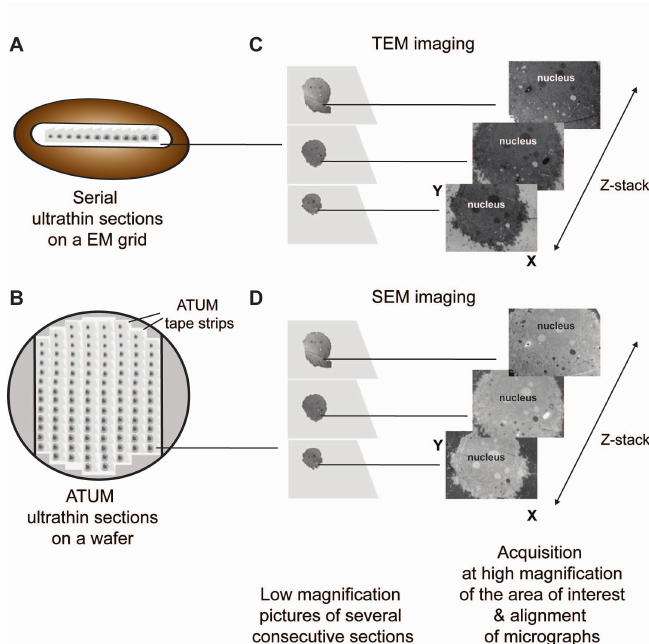
Figure 7. Serial sectioning workflow. A ribbon of consecutive ultrathin sections (60–80 nm) of a cell can be either obtained manually ( A ) or automatically on a tape (ATUM, automatic tape-collecting ultramicrotome) ( B ) and subsequently analyzed by TEM ( C ) or SEM ( D ), respectively. Generated micrographs are aligned to obtain a z-stack of this cell. Note also that the same principle is used to join tomograms obtained by